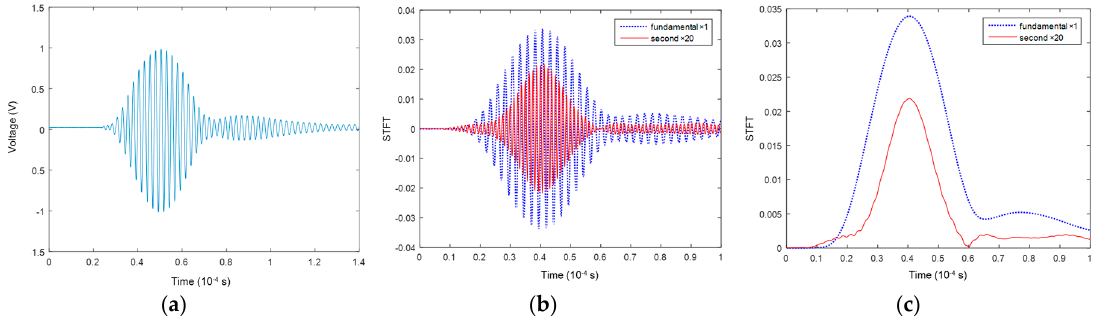
Figure 10. Signals of the mode pair S 0 -S 0 at a propagation distance of 200 mm in the experiment (second harmonic mode × 20 times in amplitude) ( a ) raw acquired signals; ( b ) separated signals of S 0 -S 0 ; and ( c ) separated energy packets of S 0 -S 0 .